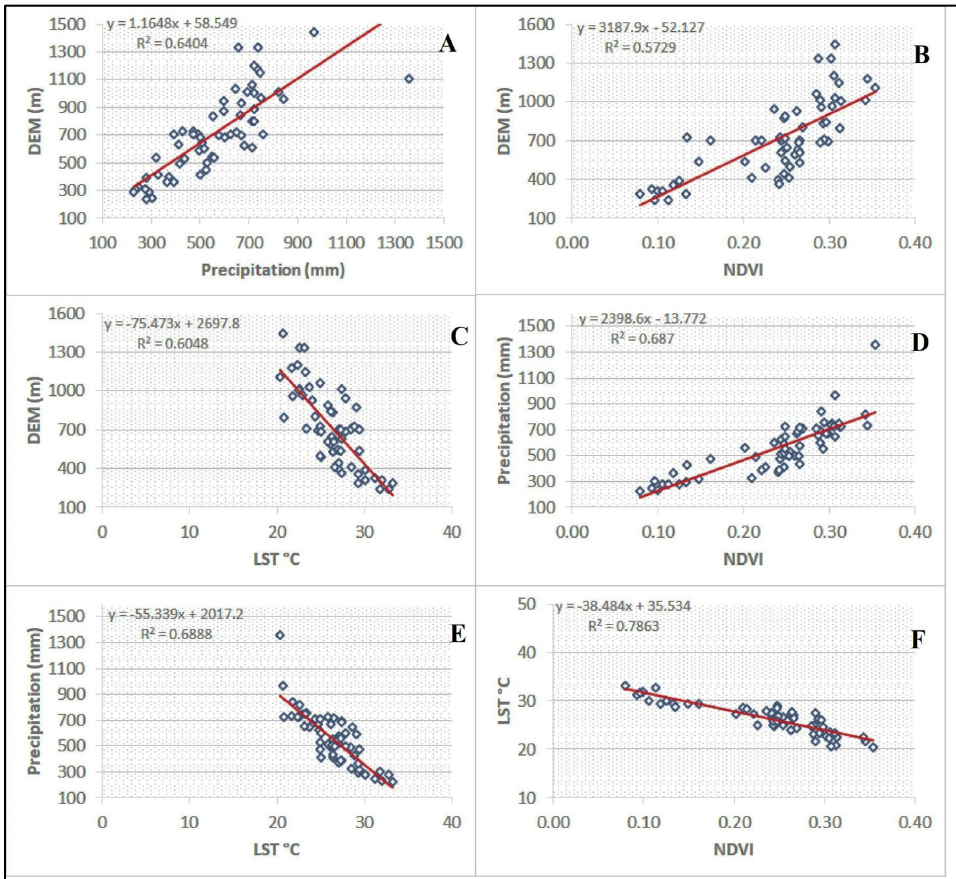
Figure 9. Spatial pattern changes of ecological parameters and drought indices for an average of 20 years in 60 locations. ( A ) Relationships between elevation precipitation. ( B ) Relationships between elevation and NDVI. ( C ) Relationships between elevation and LST. ( D ) Relationships between precipitation and NDVI. € Relationships between precipitation and LST. ( F ) Relationships between LST and NDVI.